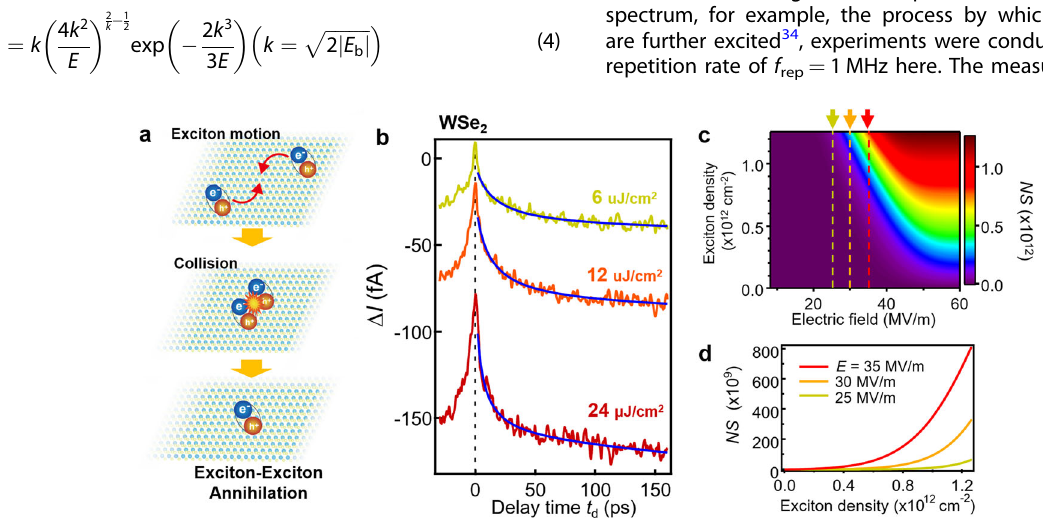
Fig. 4 Exciton-exciton annihilation dynamics. a Schematic illustrations of exciton-exciton annihilation dynamics. b TR-MP-STM signals obtained in the WSe 2 region for the fl uences of 6, 12, and 24 μ J/cm 2 . V s = + 6 V, I set = 1 pA, and f rep = 1 MHz. c Mapping of S for changes in exciton density and exciton binding energy. d Cross sections along the three lines in c. The measurements were performed at the same place as the PL measurement, indicated by the red triangle in Fig. 2a. The heterostructure interface was not exposed to